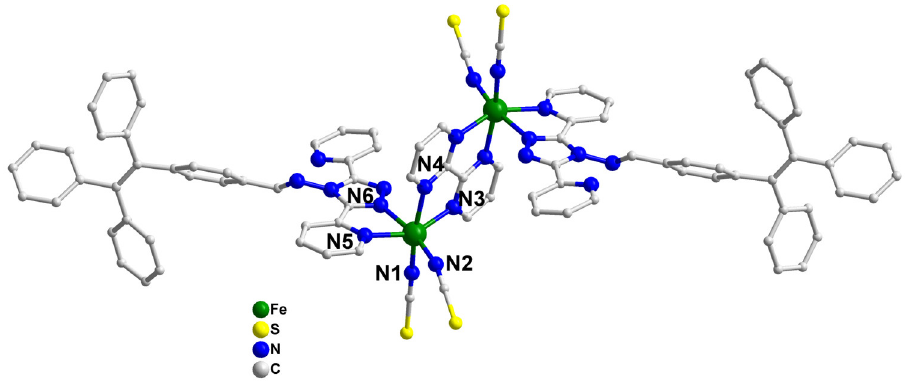
Figure 3. Molecular structure of {[Fe(abpt-TPE)(NCS) 2 ] 2 (bpym)}·2CH 2 Cl 2 ( 2 ) at 100 K. Hydrogen atoms and solvent molecules have been omitted for clarity. Table 1. Selected bond lengths [Å] and angles [°] in the structures of complex 1 at various tempera- tures.